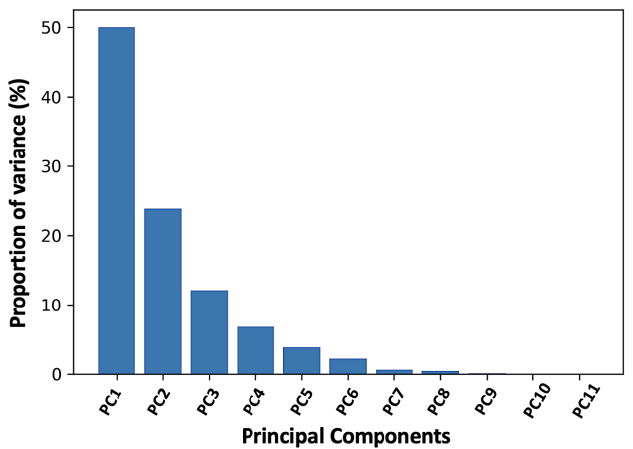
Figure 3. Scree plot to select the number of principal components (PC).